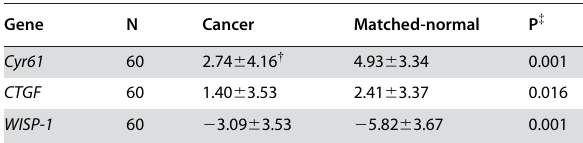
Table 1. Expression of Cyr61 , CTGF , and WISP-1 mRNA in lung